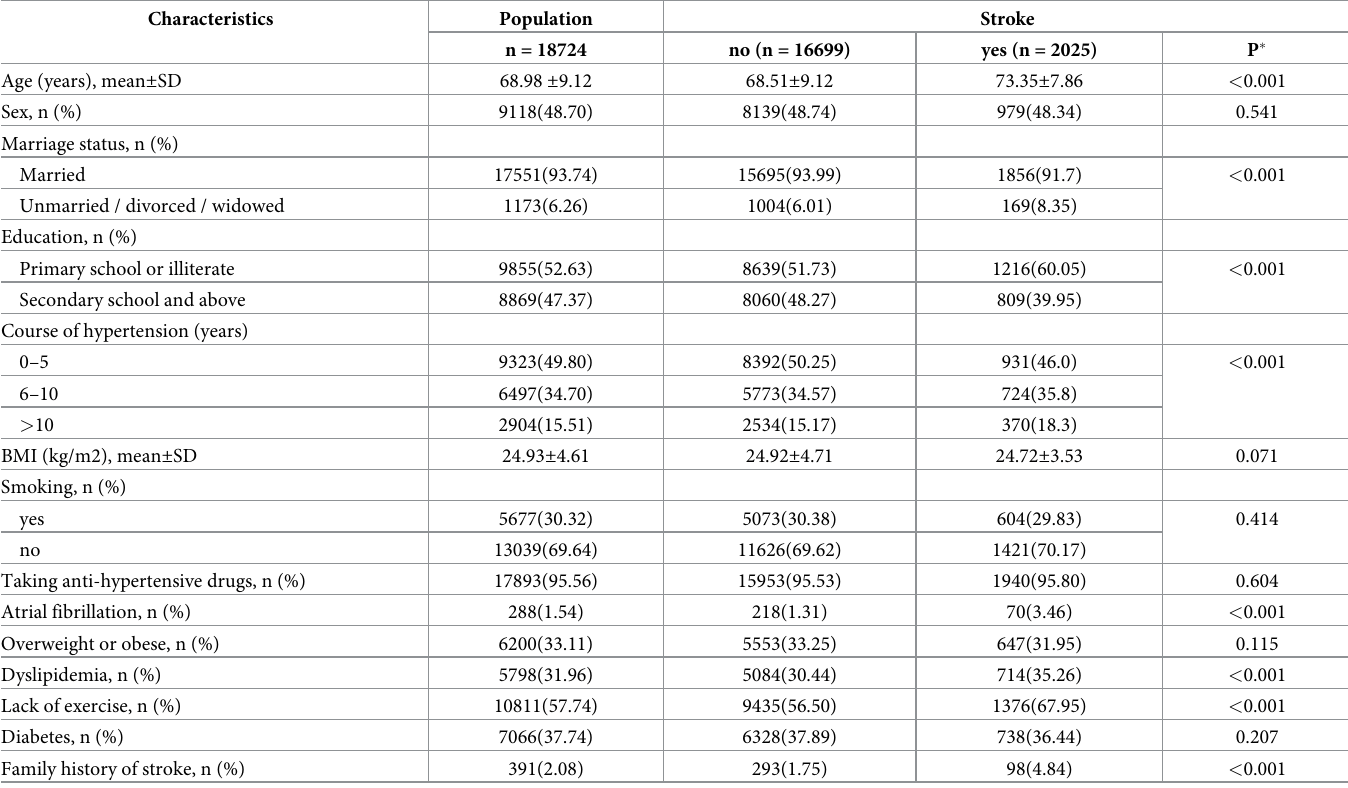
Table 1. Demographic information and clinical characteristics of study